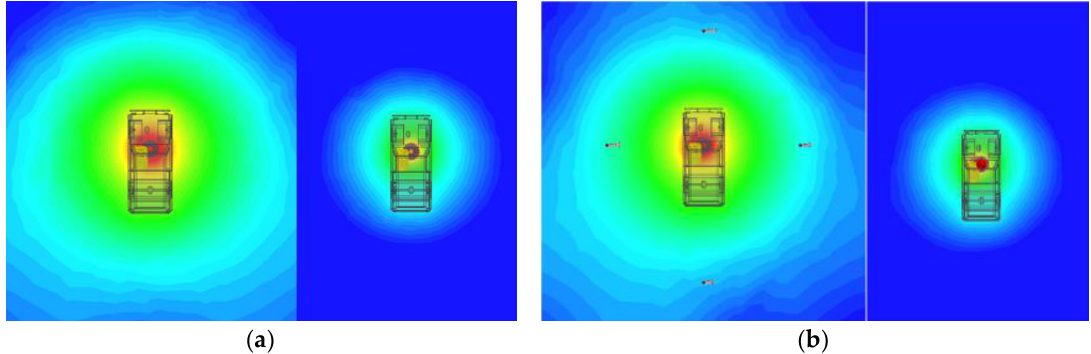
Figure 21. Far-field magnetic field distribution on fundamental current and third-order harmonic